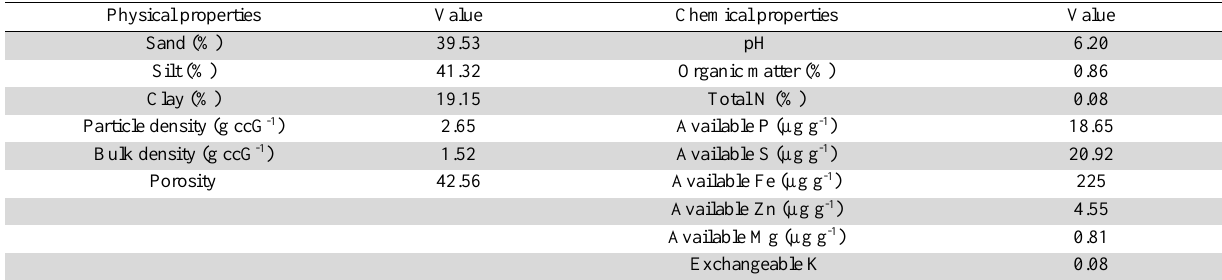
Table 1. Physical and chemical properties of the experimental field before